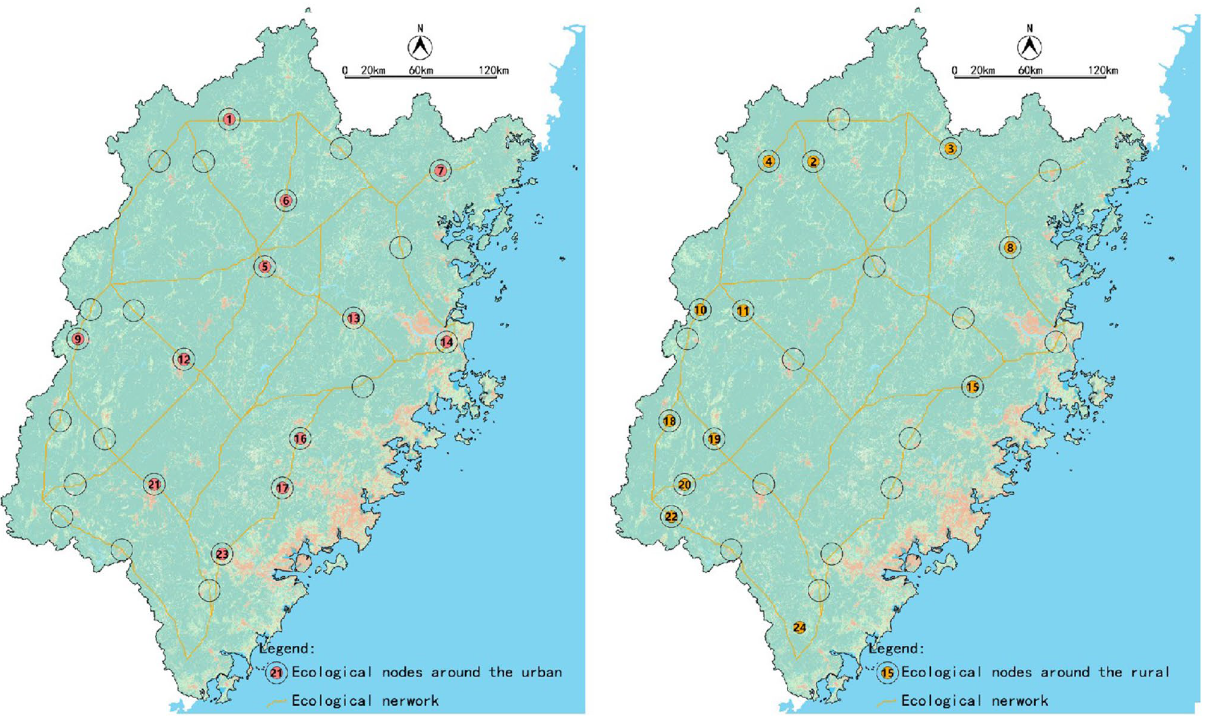
Figure 21. Two types of ecological network nodes, Fujian